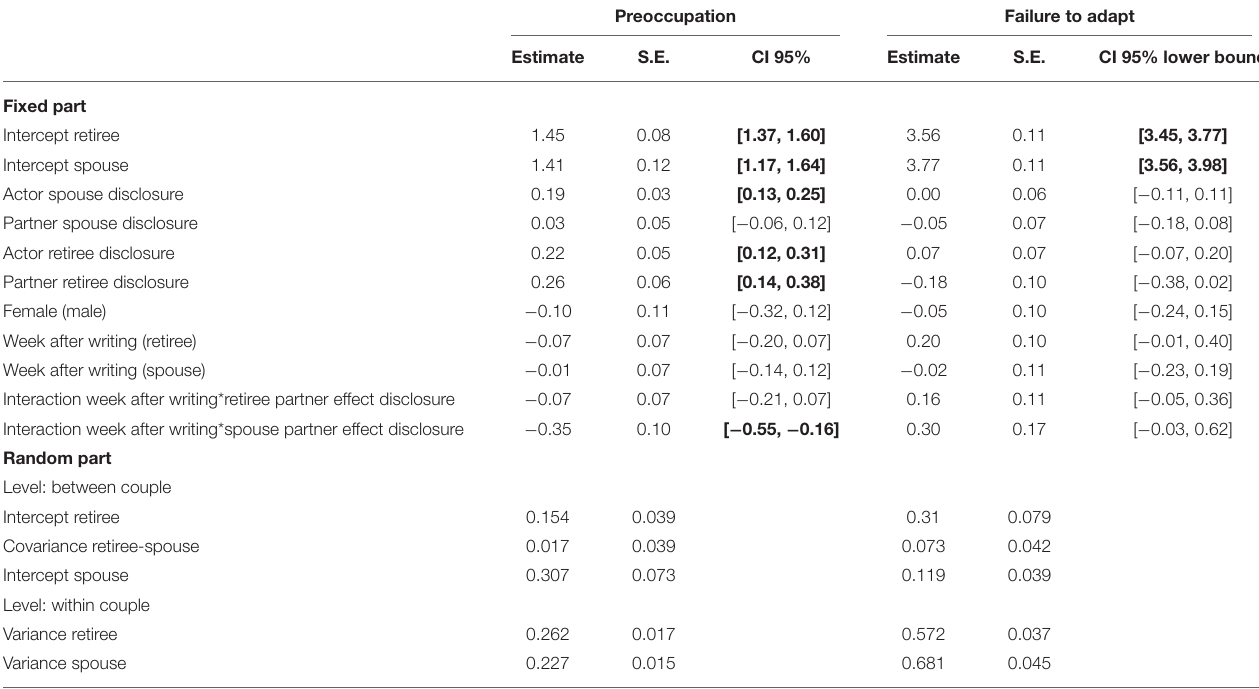
TABLE 3 | Multilevel model estimates: actor and partner effects of retirement-related disclosure on adjustment symptoms preoccupation and failure to